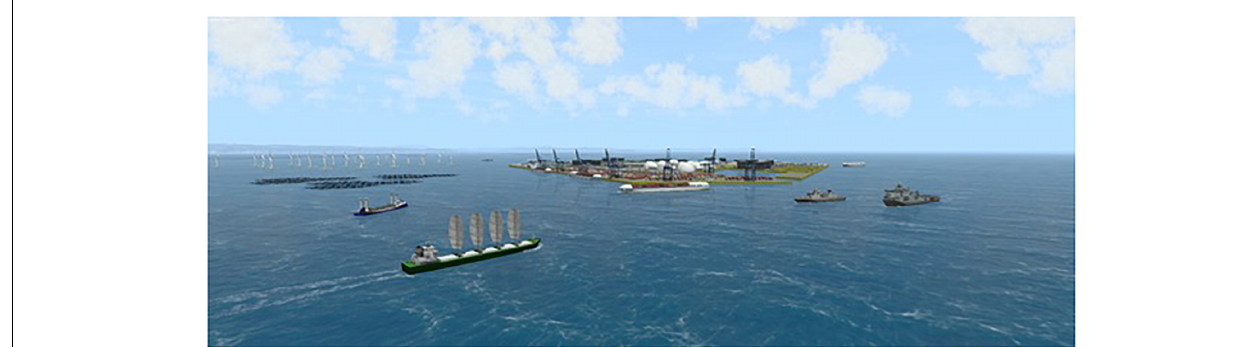
FIGURE 1 | Impression of a floating energy and logistics island.